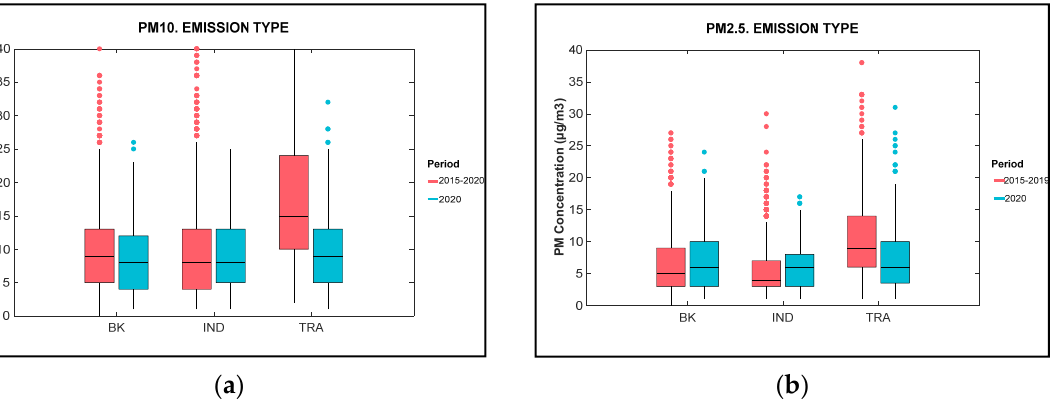
Figure 5. ( a , b ) Box plots by emission type. ( a , b ) represent PM 10 and PM 2.5 respectively in the reference and the lockdown periods. The marker inside the boxplot is the median, and lower and upper box boundaries are the 25th (Q1) and 75th (Q3) percentiles, respectively. Lower and upper whiskers represent Q1 − 1.5·IQR and Q3 + 1.5·IQR, respectively. Dots are outliers.